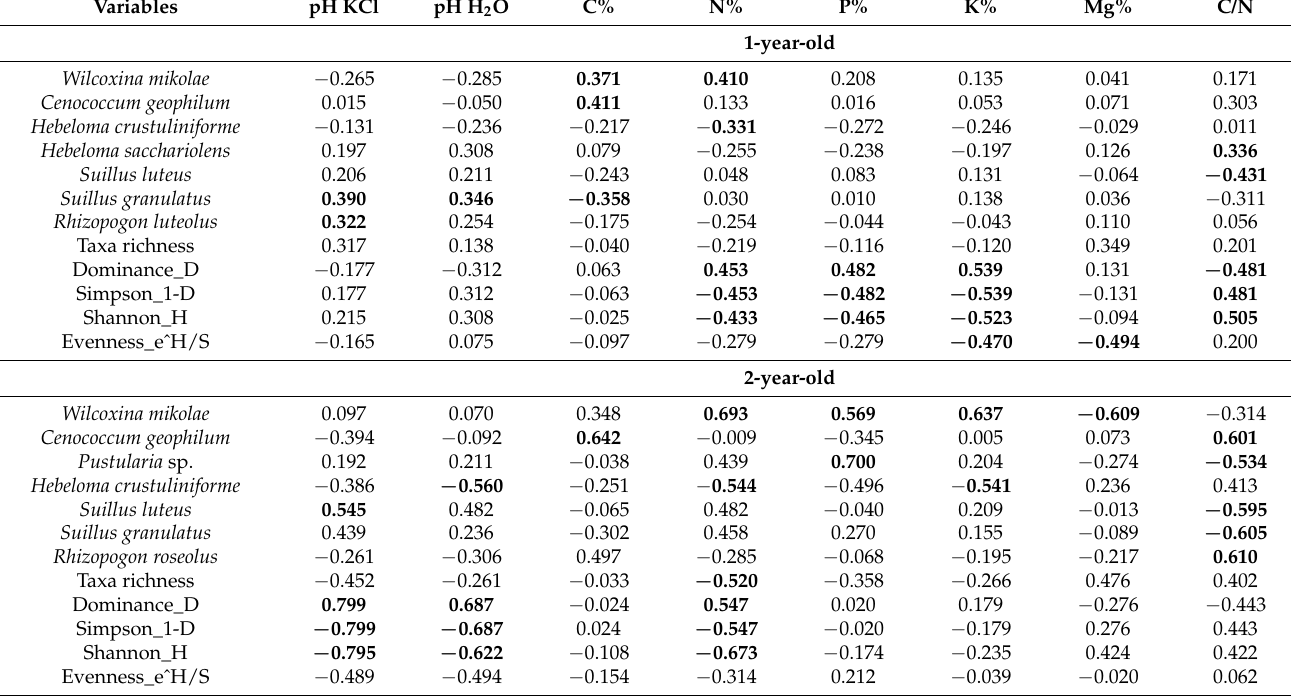
Table 4. Spearman’s rank correlation between relative abundance of ectomycorrhizal fungal species, and soil parameters and Pearson’s correlation between taxa richness and diversity indices and soil parameters in forest nurseries (data presented only for species for which significant correlations were